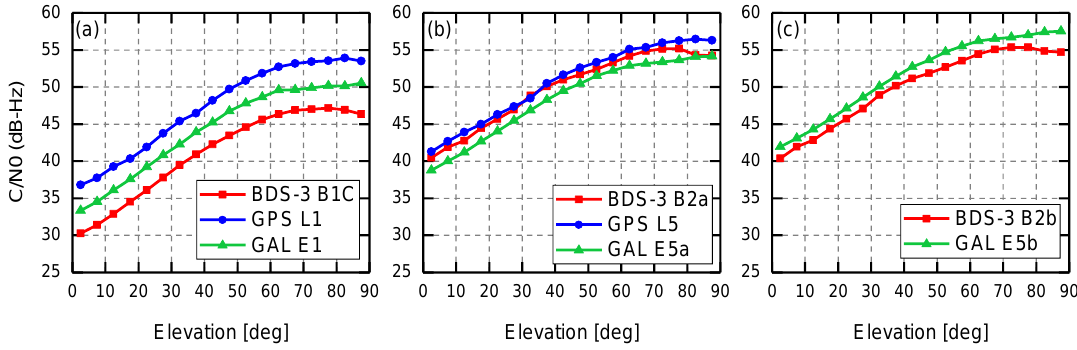
Figure 3. Mean C/N 0 values as a function of elevation for the signals with overlapping frequencies of BDS-3, GPS, and Galileo at ABJA station. The signals include B1C/L1/E1 ( a ); B2a/L5/E5a ( b ); and B2b/E5b ( c